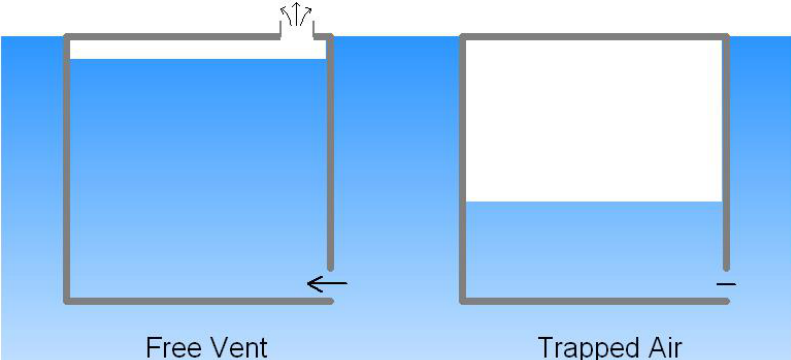
Figure 2. Comparison of flooding characteristics between watertight (trapped air) and non-watertight (free vent) spaces; Arrows show the flow of water (blue colored) and air (white colored) and hyphen means there are no flow of water.